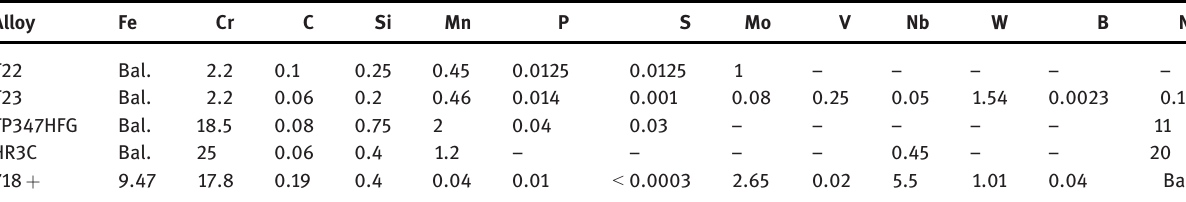
Table 1: Chemical compositions of the alloys used in this study in wt%. Alloy